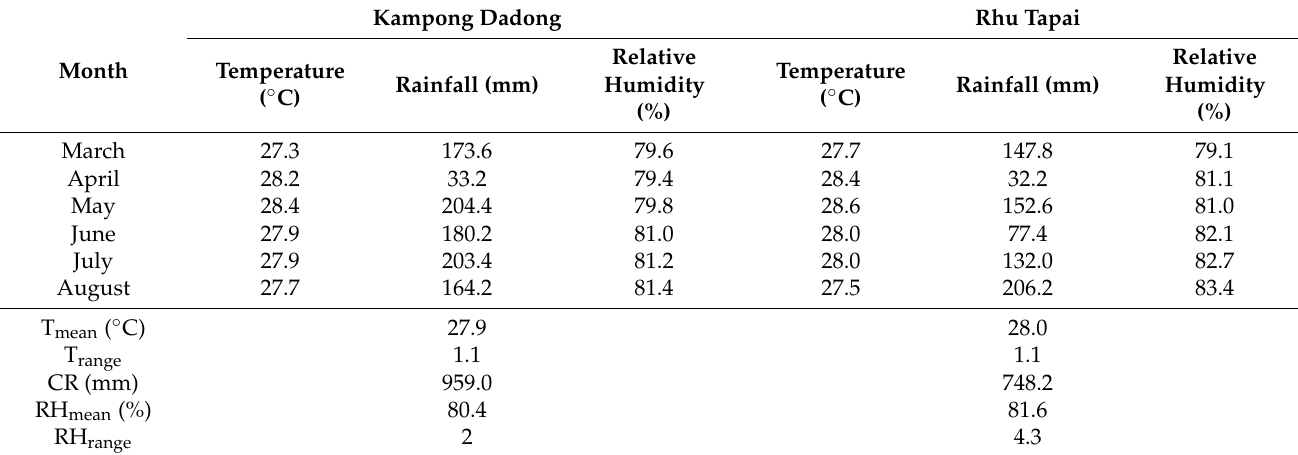
Table 1. Monthly mean temperature ( ◦ C), rainfall (mm), and relative humidity (%) during the 2017 cropping season of grain corn from Kampong Dadong and Rhu Tapai grain corn farms in Terengganu. Data were supplied by the Malaysian Meteorological Department, Ministry of Energy, Science, Technology, Environment, and Climate Change, and obtained from the closest meteorological station to the grain corn